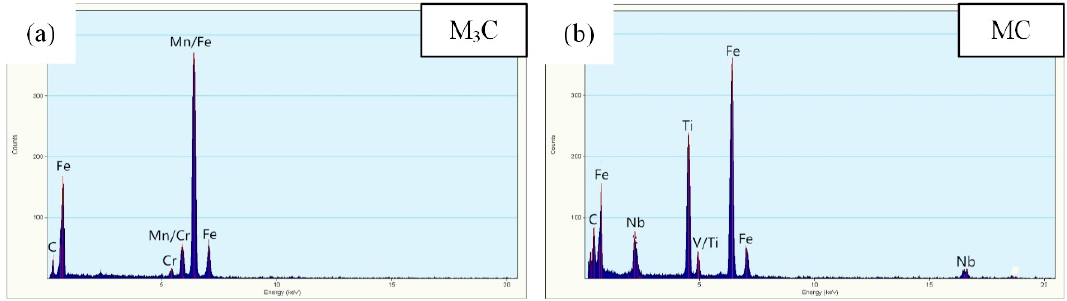
Figure 7. Energy Dispersive Spectrometer(EDS) analysis of precipitates in the tempered SA738 Gr.B steel. ( a ) M 3 C; ( b ) MC.